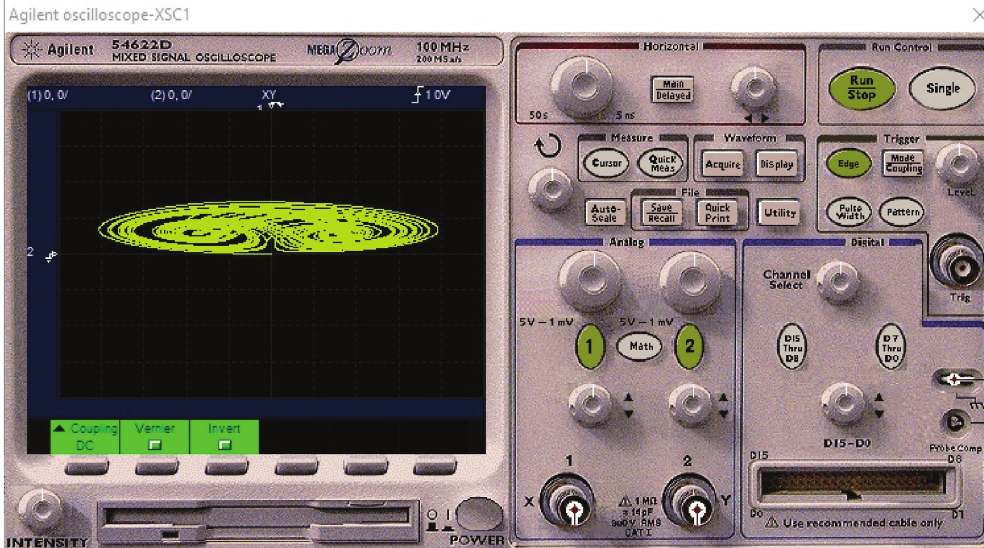
with respect to the state variable x 3